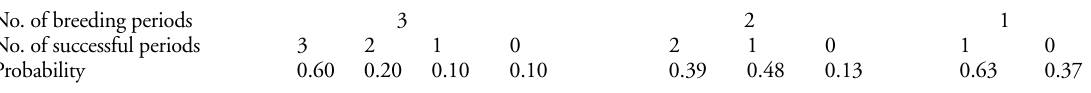
Table 3. Parameter overview for the stochastic simulation model. Maximum age: 7 yr. Age of maturity: 2 yr Probabilities for environmental conditions influencing reproduction and number of breeding periods No. of breeding periods No. of successful periods